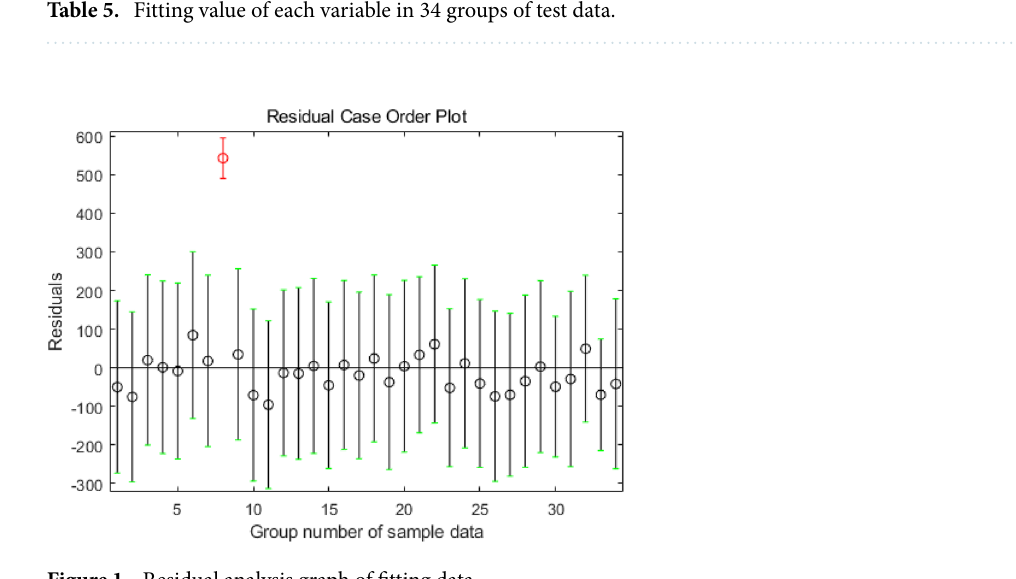
Figure 1. Residual analysis graph of fitting